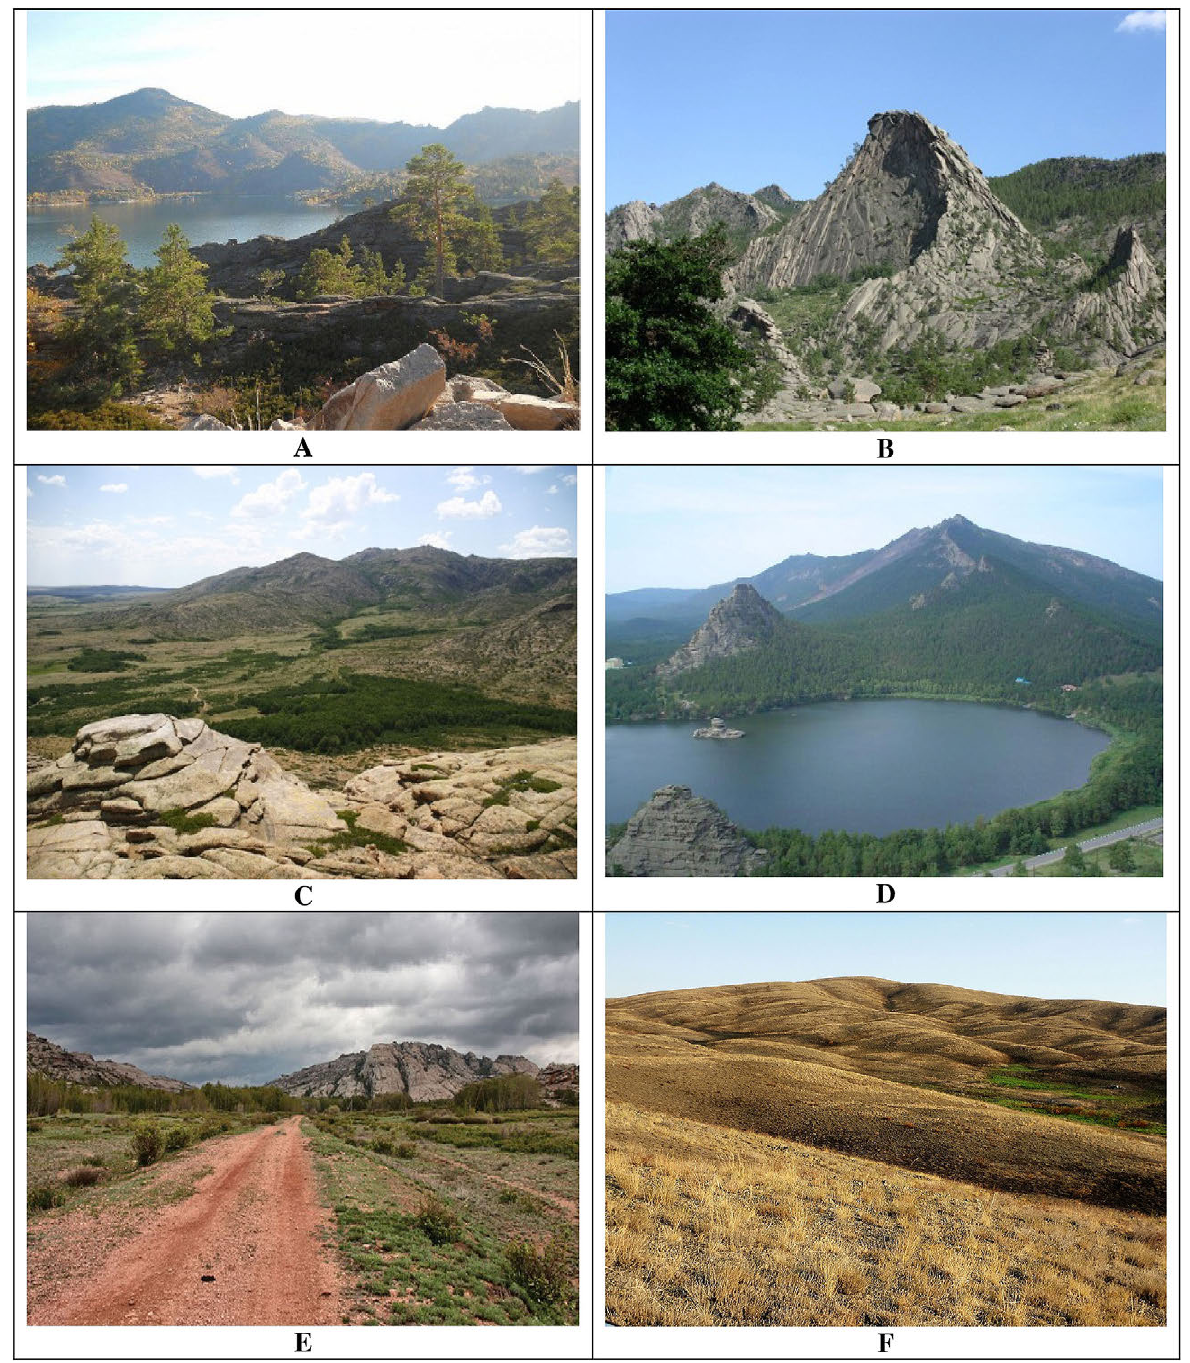
Fig. 5. Present landscape physiography associated with the discussed oronyms in north-central and eastern Kazakhstan (Sary-Arka). A. Bayanaul Mountains (700–1,000 m a.s.l.) shaped by Palaeozoic orogenesis with Lake Zhasybay (Pavlodar Region); B. Bayanaul – the Akbet Mt. (1,022 m) near Lake Toraigyr; C. Ulytau Mountains (1,133 m a.s.l.) structured of granitic massifs with canyon-shaped planation relief of colorful stratified Mesozoic sedimentary rocks (Ulytau Region); D. Kokshetau Mountains (947 m a.s.l.) with Borovoye/ Buragay (Pine Forest) Lake (Akmola Region); E. Kyzylarai Mountains – Aksoran Mt. (1,565 m), the highest peak of central Kazakhstan (Karaganda Region); F. Mugodzhary Hills (average elevation 400–500 m a.s.l.) formed by the Pre-Cambrian Earth crust uplift and situated in open steppe connecting to the Southern Urals (Aktobe